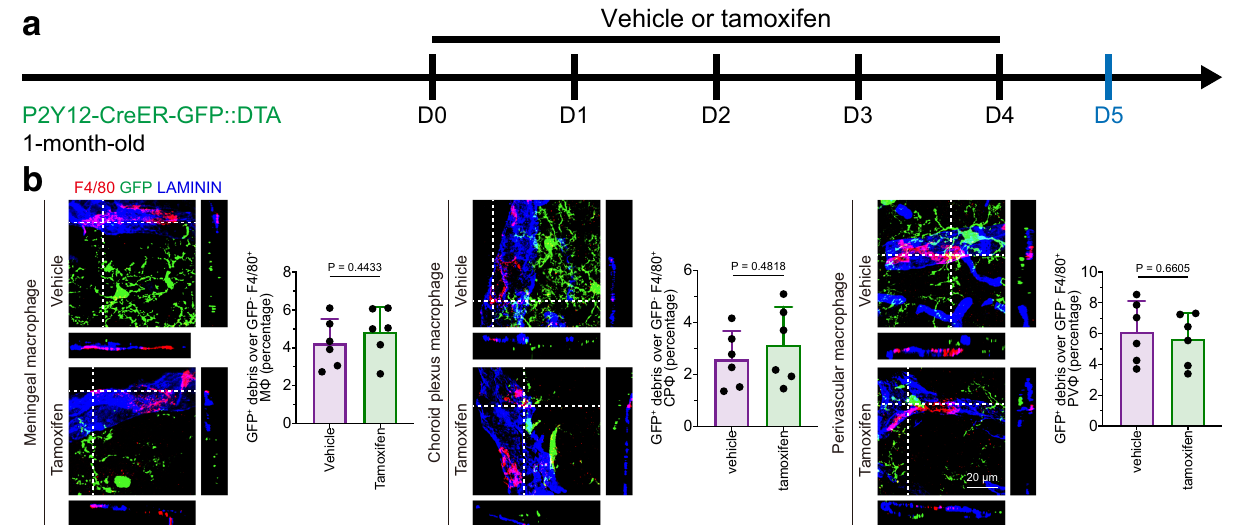
Fig. 5 | BAMs do not engulf microglial debris in vivo. a Scheme of tamoxifen- triggered microglial cell death for investigating the BAM engulfment capacity of microglial debris. b Meningeal, choroid plexus or perivascular macro- phages do not engulf parenchymal microglia upon microglial ablation. N = 6